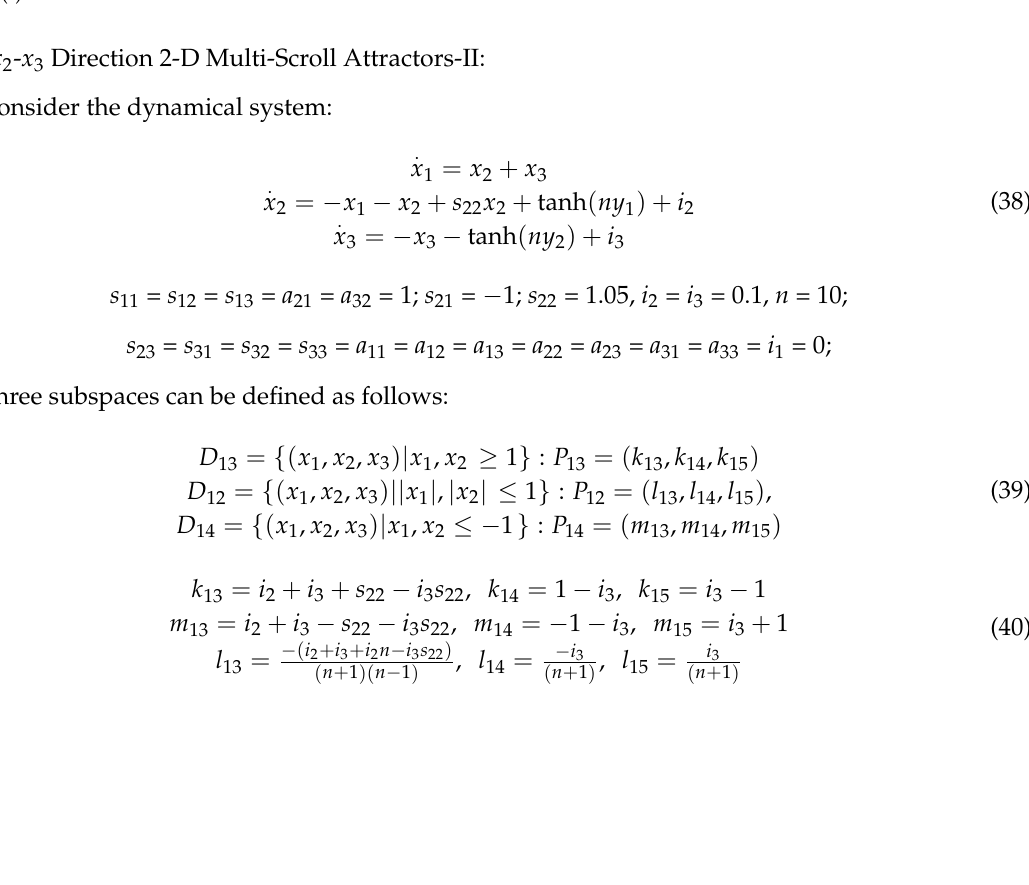
Figure 8. Numerical results of the x 2 - x 3 direction 2-D multi-scroll SC-CNN based system-I: ( a ) 2-doublescroll in x 1 - x 2 - x 3 plane; ( b ) variable x 1 (t); ( c ) 4-double scrollin x 1 - x 2 - x 3 plane; and ( d ) variable x 2 (t).